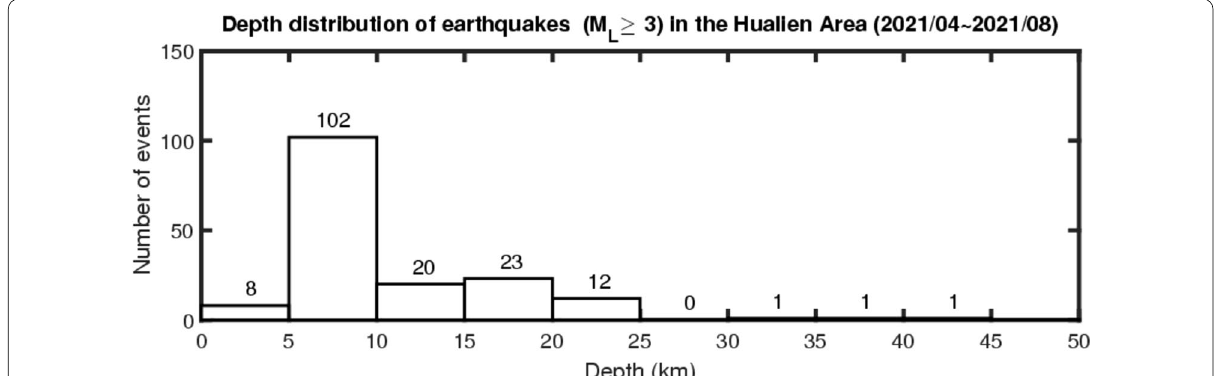
Fig. 3 The depth distribution of number of M L